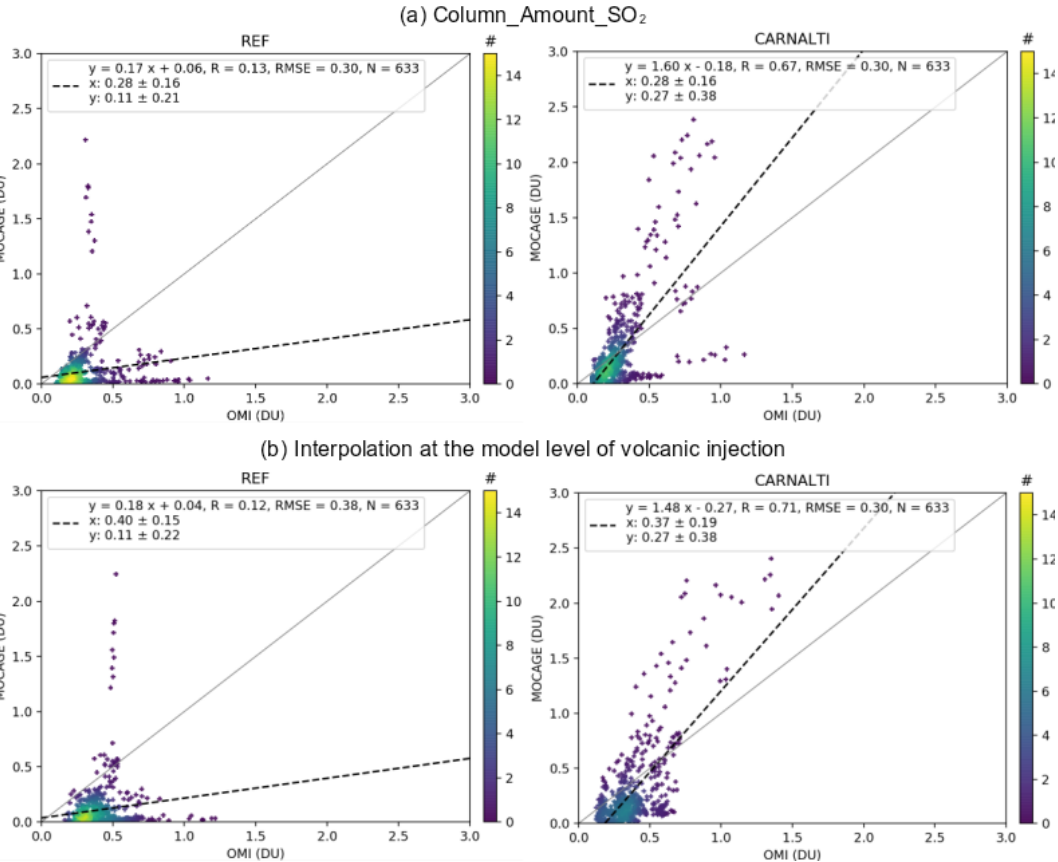
Figure 4. Scatterplots of annual mean OMI SO 2 versus MOCAGE simulations (left – REF; right – CARNALTI) (a) considering total columns and (b) interpolating at the model level where volcanic emissions are injected. Also shown are the 1 : 1 line (solid gray), linear regression line (black dash), linear regression formula, correlation coefficient ( R ), root mean squared error (RMSE), number of collocated pairs ( N ), OMI mean and standard deviation in DU ( x ), MOCAGE mean and standard deviation in DU ( y ) and density of collocated pairs (color bar). Table 3. The 2013 annual statistics of the REF and CARNALTI simulations against MODIS observations on specific zones. Globe Zone 1 Zone 2 Zone 3 MNMB FGE R MNMB FGE R MNMB FGE R MNMB FGE R REF 0.10